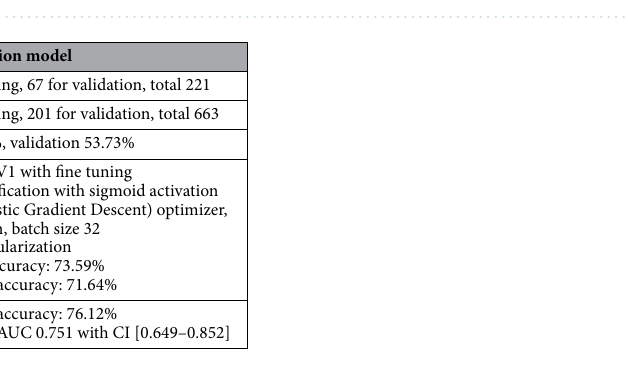
Figure 2. Three axial consecutive brain T2-magnetic resonance images from a 67-year-old man with left corona radiata infarct.